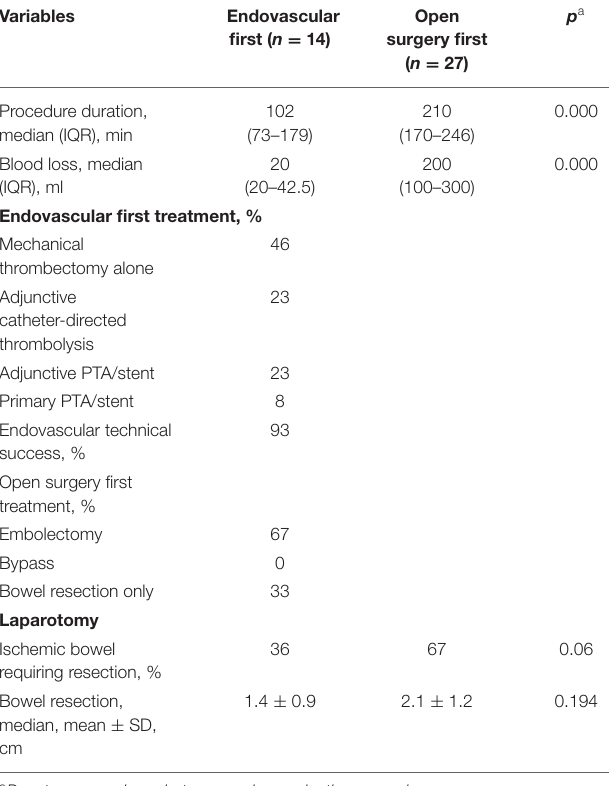
TABLE 4 | Univariate associations with mortality among superior mesenteric artery embolism